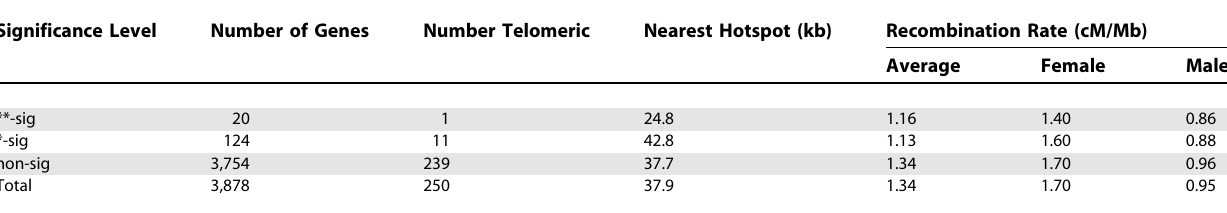
Table 9. Recombination Rate in Genes with Evidence for Positive Selection Based on MK Tests Significance